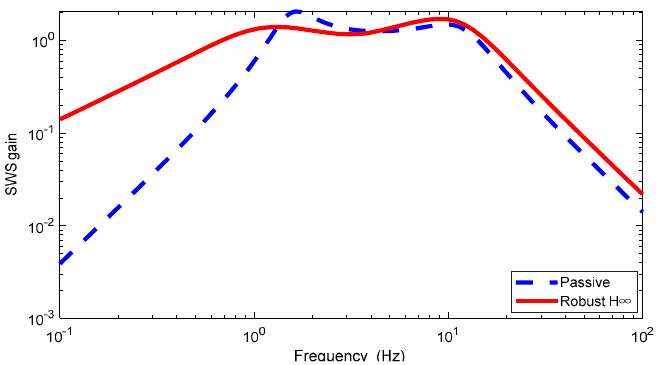
Figure 5. The frequency response of suspension working space of the closed-loop system.